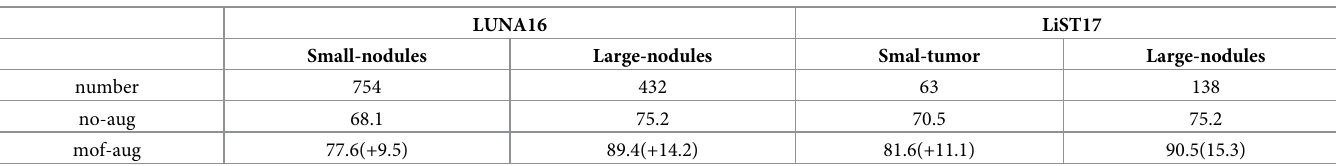
Table 8. Effectiveness of Mask RCNN to the lesion size